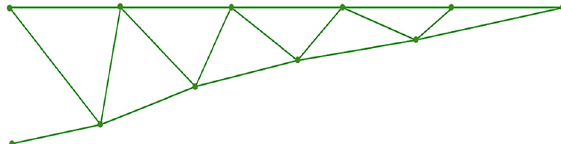
Fig. 6. Optimal layout for the planar 18-bar truss problem